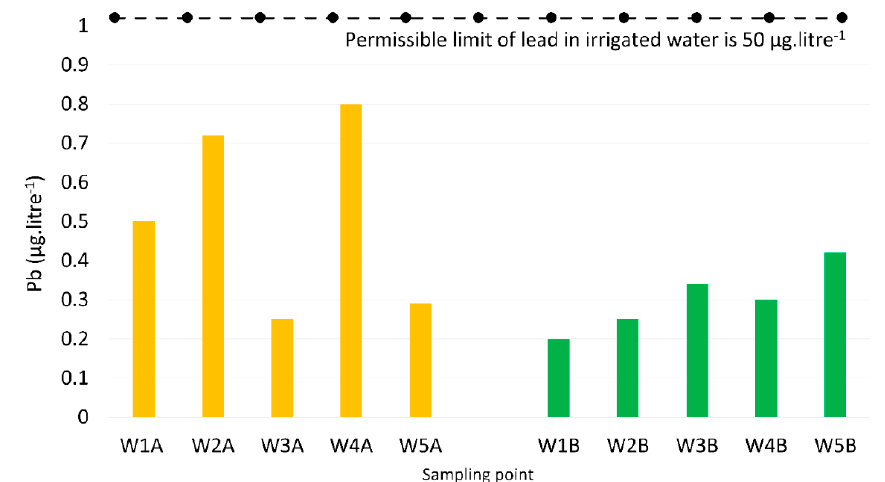
Figure 3. Lead concentrations of samples measured from irrigated water resources near ( left ) and far away ( right ) from the bus station.